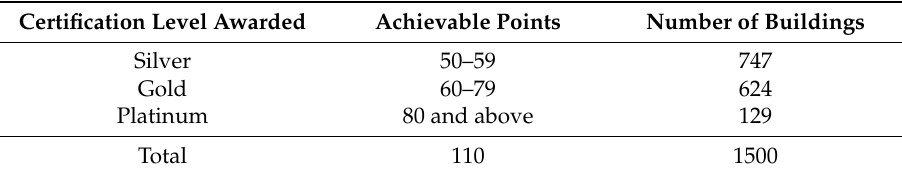
Table 2. Breakdown of buildings by certification